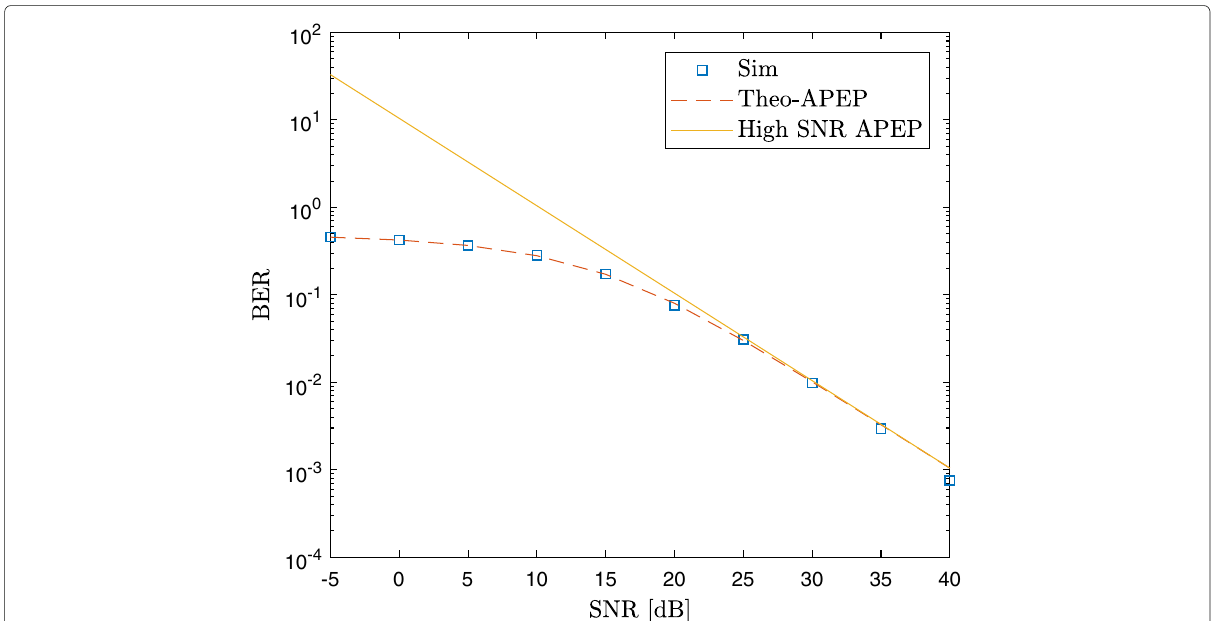
Fig. 7 ABEP of RecAnt-SM ( P = 2, N r = 1, M = 2 (BPSK)). The results are obtained by using RP 1 and RP 2